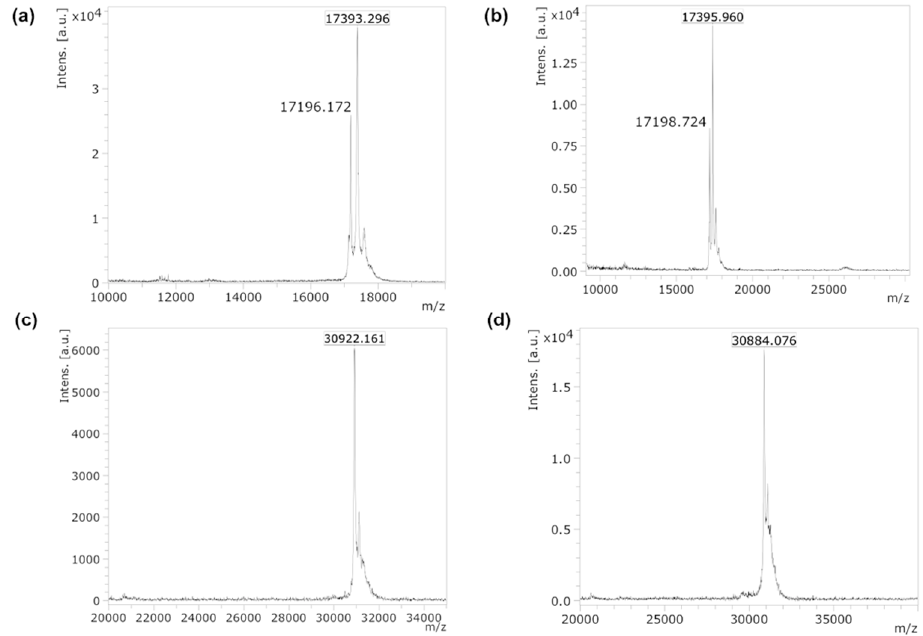
Figure 4. Maldi TOF MS analysis of protein samples. We obtained mass values of 17,393 and 17,396 for the Ub 2 (48)-S-TNB ( a ) and Ub 2 (63)-S-TNB ( b ) adducts, respectively (expected mass 17397), where TNB stands for (2-nitro-5-thiobenzoic acid). In ( a ) and ( b ), the MS peak of the unconjugated Ub 2 (48/63)SH protein is also present (expected mass 17200). We obtained mass values of 30,922 and 30,884 for the Ub 2 (48)tau4RD(353) ( c ) and Ub 2 (63)tau4RD(353) ( d ), respectively (expected mass 30923).